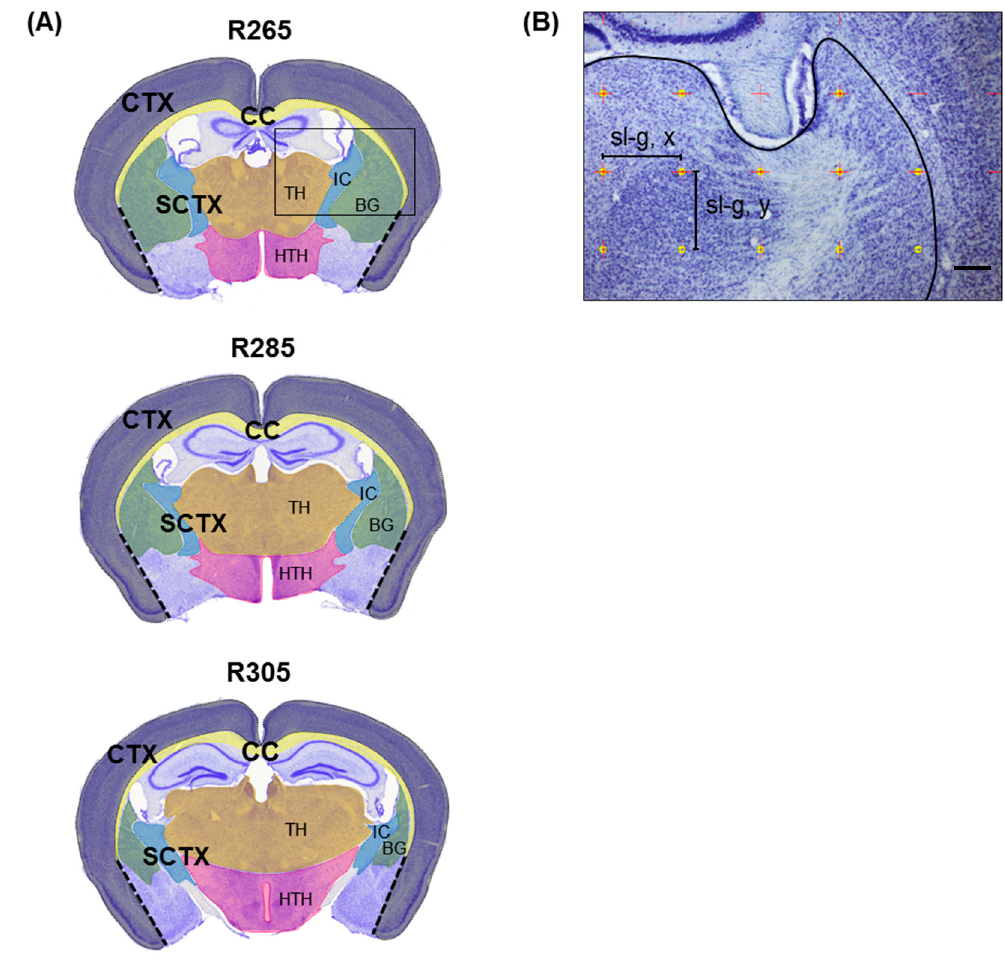
Figure 1. ( A ) Representative coronal sections of a mouse brain at levels R265, R285, and R305 (according to Reference [33]) showing regions investigated in the present study (corpus callosum (CC, yellow); cerebral cortex (CTX, gray); thalamus (TH, brown); hypothalamus (HTH, pink); internal capsule (IC, blue); basal ganglia (BG, green)). ( B ) Representative photomicrograph of a Nissl-stained coronal section (enlarged view of black square in ( A )). The slide is superimposed with a rectangular grid (intersections are represented by red crosses; sl-g = side length in x- and y -directions of the grid) to estimate the volume of the designated areas. Grid intersections within the subcortical area are highlighted as yellow dots. Scale bar in ( B ) = 1 mm ( A ) and 200 µ m ( B